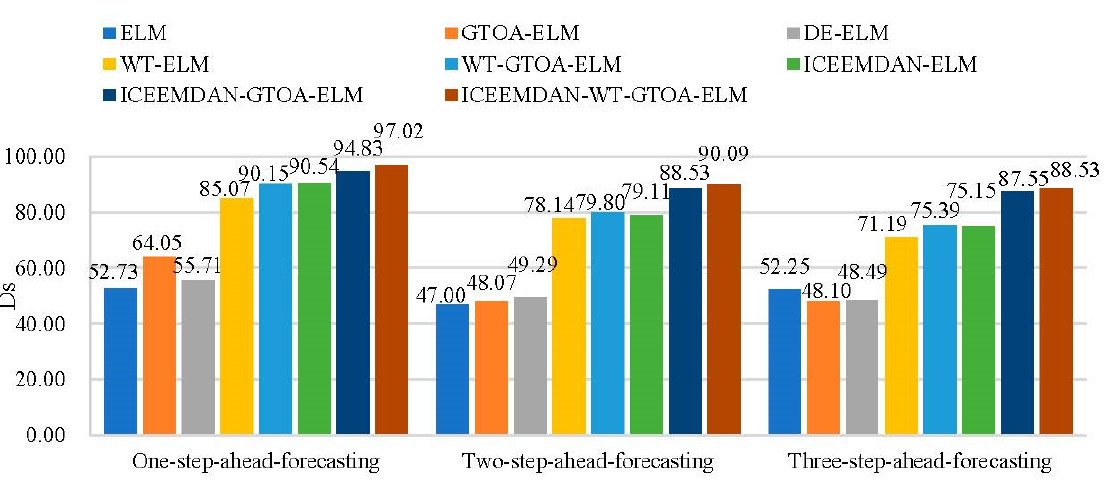
Figure 8. Direction statistics (Ds) of PM10 forecasting. Table 1. DM test results of one-step ahead forecasting of